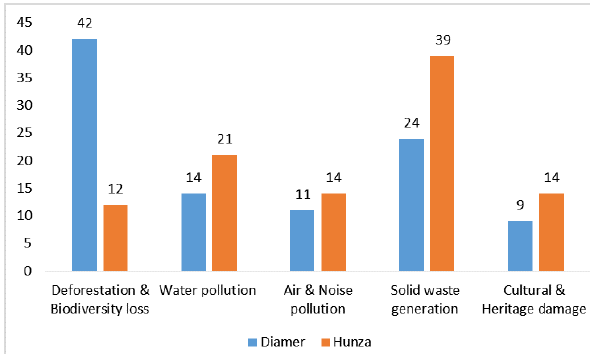
Fig. 5. Environmental issues in the districts of Diamer & Hunza